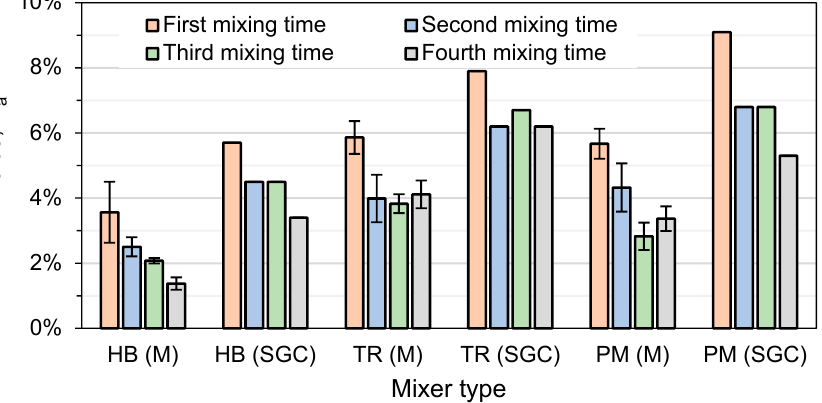
Figure 7. Effective volume of asphalt binder (V be ) and voids filled with asphalt (VFA) in the function of the air voids (V a ) at N design .